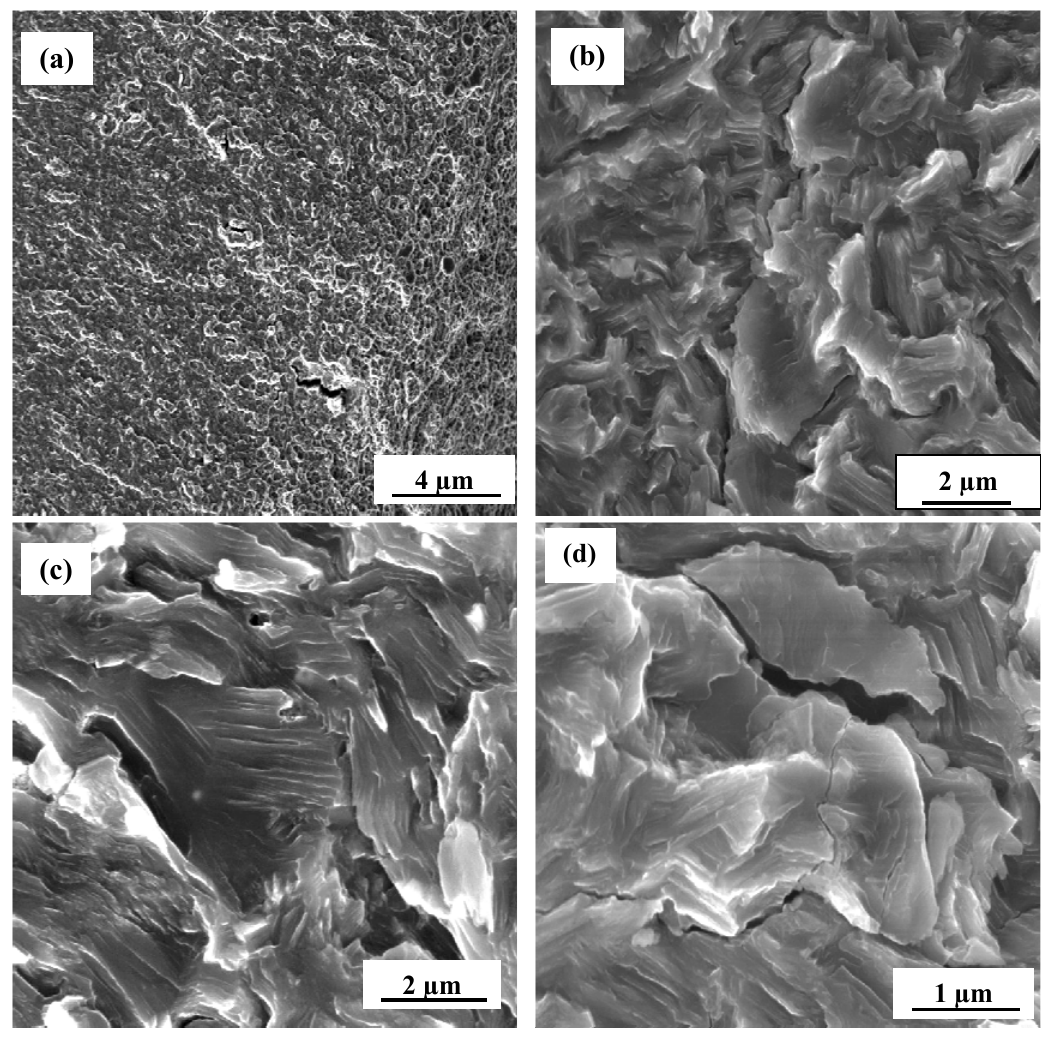
Figure 11. Scanning electron micrographs of the high cycle fatigue fracture surface of AZ31 deformed at maximum cyclic stress of 102 MPa at load ratio of 0.1, fatigue life of 197,813 cycles, showing the following: ( a ) The region of crack initiation and early microscopic crack growth; ( b ) A random dispersion of fine striations in the region of early microscopic crack growth; ( c ) High magnification observation if (a) showing the nature and distribution of striations in the region of early crack growth; ( d ) Cracking along the grain boundaries observed immediately prior to unstable crack